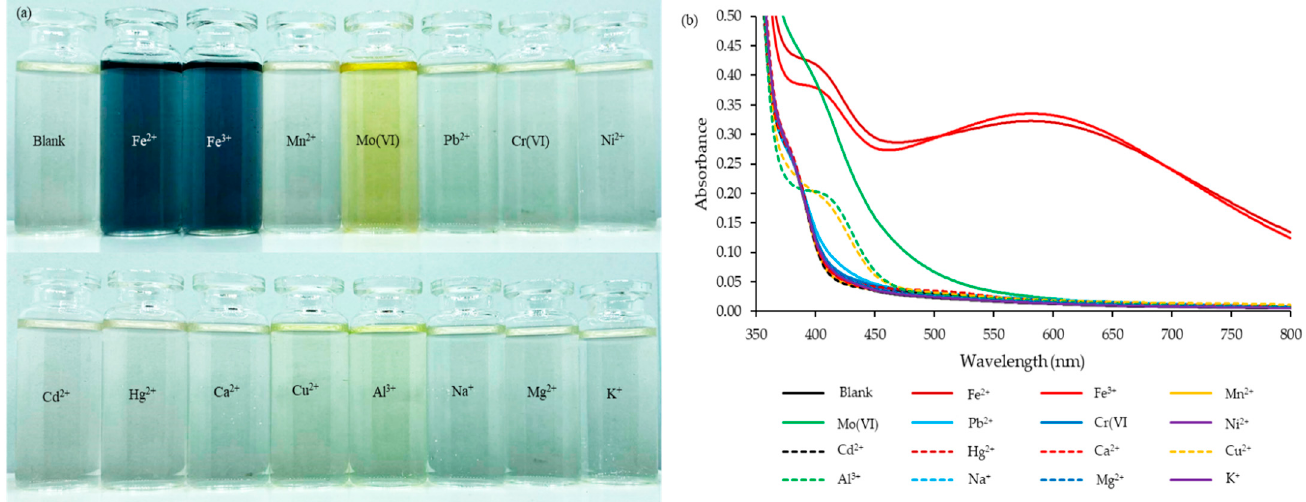
Figure 1. Results of the reaction between the natural reagent and various metal ions ( a ) Digital images; ( b ) absorption spectra under 1 mL of natural reagent, 10 mg·L − 1 of each metal ion ( ― Blank; ― Fe 2+ ; ― Fe 3+ ; ― Mn 2+ ; ― Mo(VI); ― Pb 2+ ; ― Cr(VI); ― Ni 2+ ; ---- Cd 2+ ; ---- Hg 2+ ; ---- Ca 2+ ; ---- Cu 2+ ; -